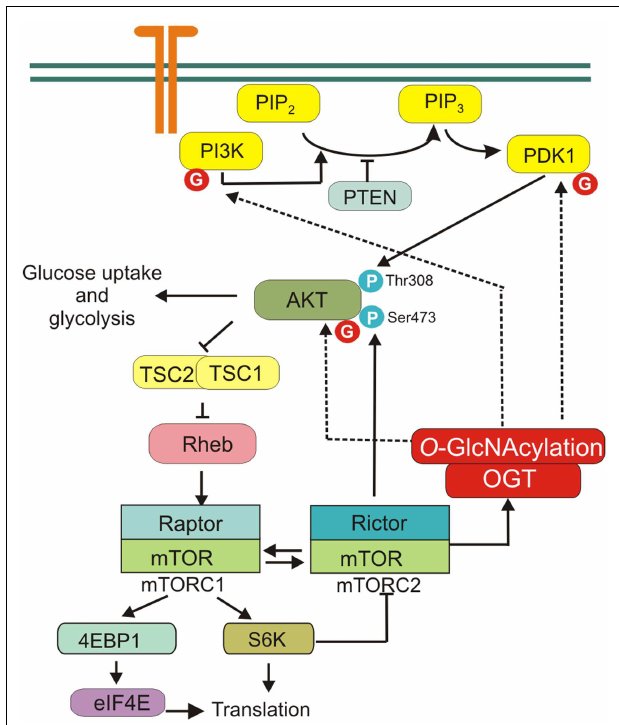
FIGURE 3 | PI3K/Akt/mTOR signaling pathway . mTORC1 is activated by receptor signaling through the PI3K/Akt pathway. mTORC2 is crucial factor in PI3K/Akt signaling, phosphorylating Akt on Ser473 to promote its maximal activation. mTOR regulates protein O -GlcNAcylation through affecting OGT stability. Several proteins of PI3K/Akt/mTOR pathway are modified by OGT, i.e., PI3K, PDK1, and